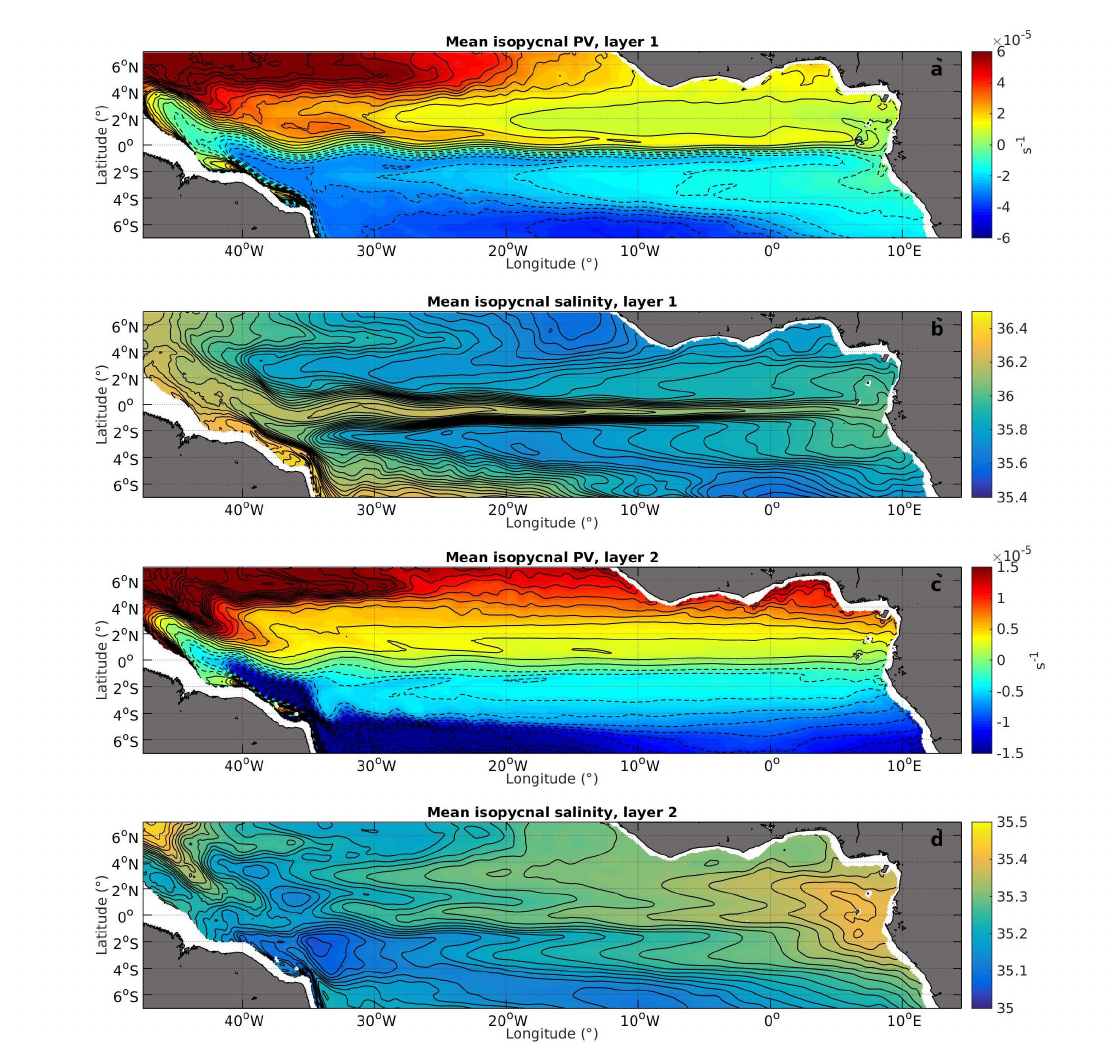
Figure 5. Horizontal map of the PV fields averaged over 2015 and between isopycnic levels defining layers 1 and 2 ( a , c , respectively), and horizontal map of the PV fields averaged over 2015 and between isopycnic levels defining layers 1 and 2 ( b , d , respectively).